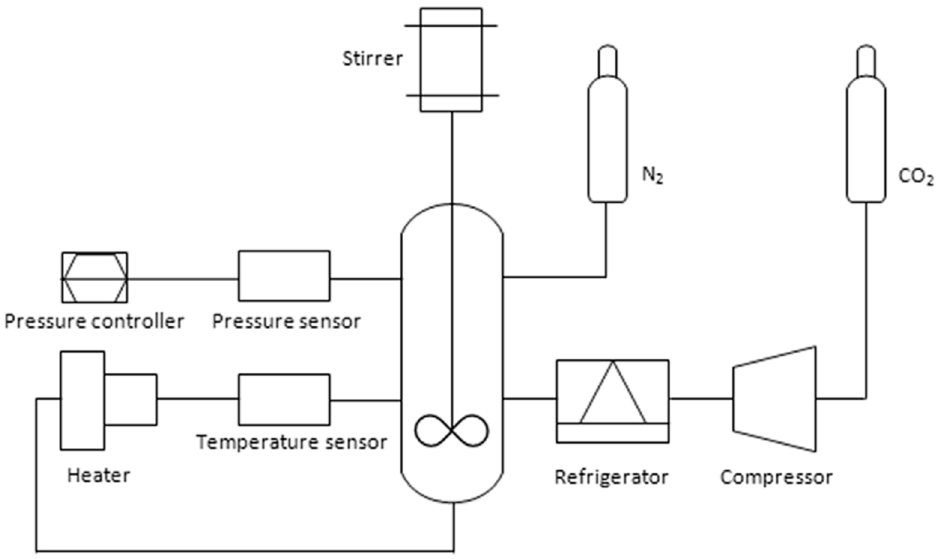
Figure 1. Experimental setup scheme for synthesis of PCL- g -GMA in scCO 2.